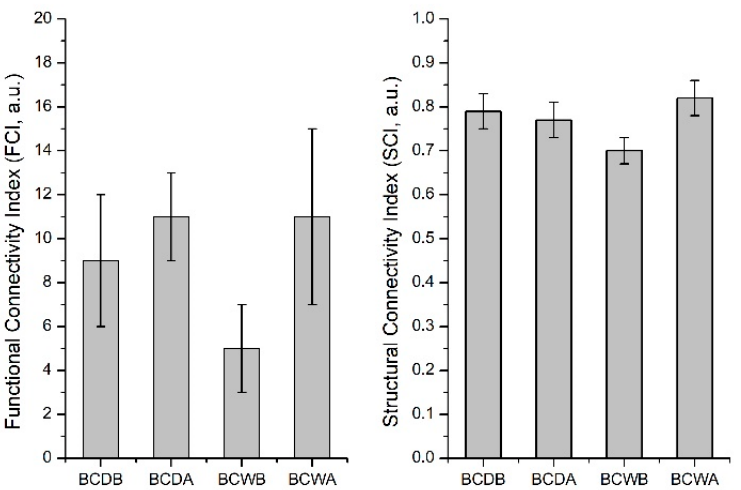
Figure 3. Mean and standard deviation values of Functional Connectivity Index ( FCI ) and Structural Connectivity Index ( SCI ). The values were obtained by averaging the FCI and SCI values at each ν L . The acronyms on the horizontal axes must be interpreted as it follows: BC stands for biochar, D and W lay for dry − quench and wet − quench, respectively, B and A stand for before and after application to soil.